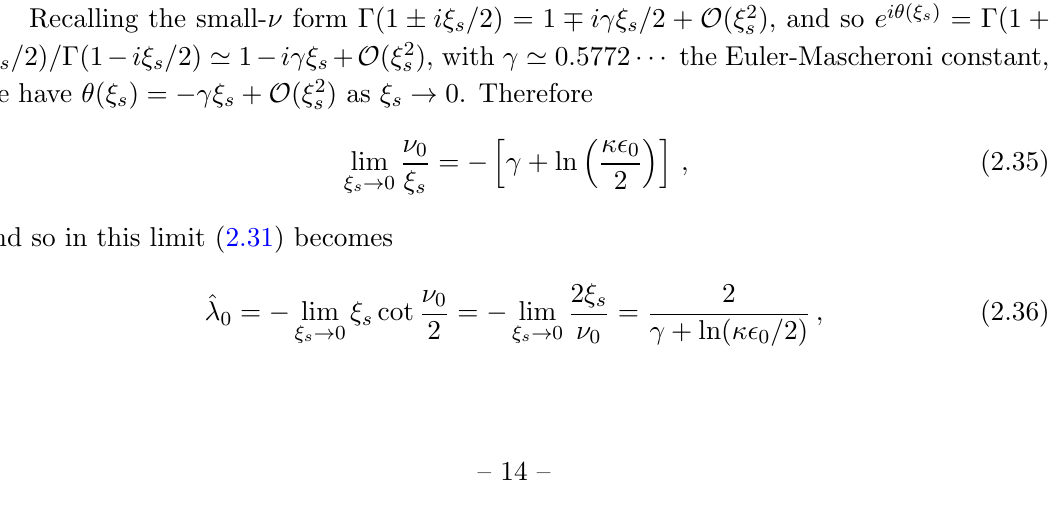
j is greater than the UV n